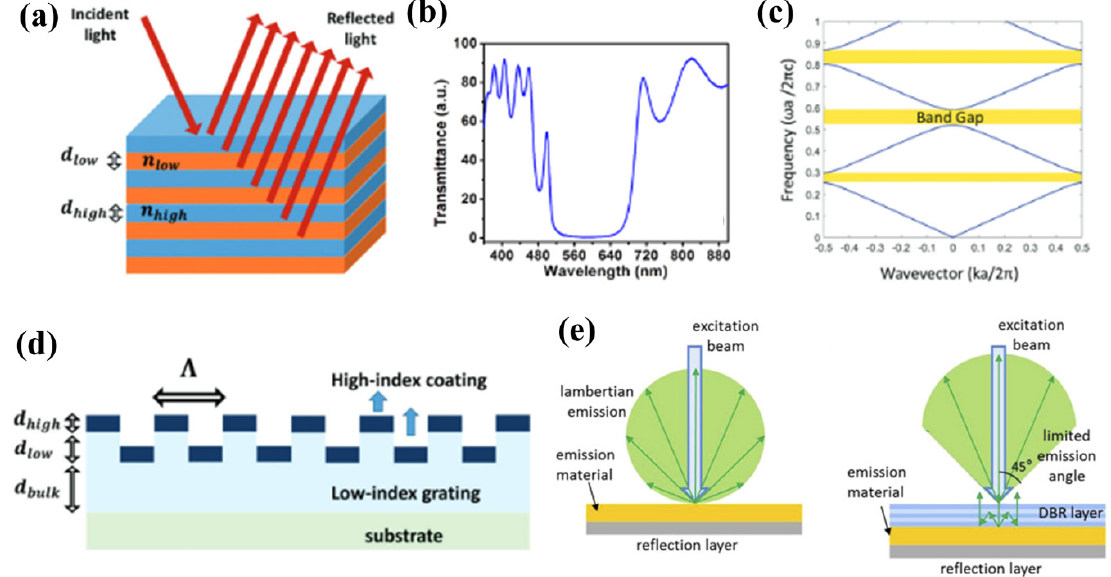
Figure 1. ( a ) A Bragg reflector showing the increased total reflection due to consecutive layers of high and low refractive index, adapted with permission from [38]. ( b ) Transmittance spectrum of a Bragg reflector, adapted with permission from [43]. ( c ) Example of band gap structure of a 1D PC. ( d ) Example structure of 1D PC slab with an alternating grating of high and low reflective index, adapted with permission from [38]. ( e ) Example emission of the guided emission from a distributed Bragg reflector (DBR) versus a non ‐ optically active material, adapted with permission from [95]. Two ‐ dimensional PCs have periodicity in two spatial dimensions and thus can be manipulated for properties such as diffraction and reflection enhancement [99,100].